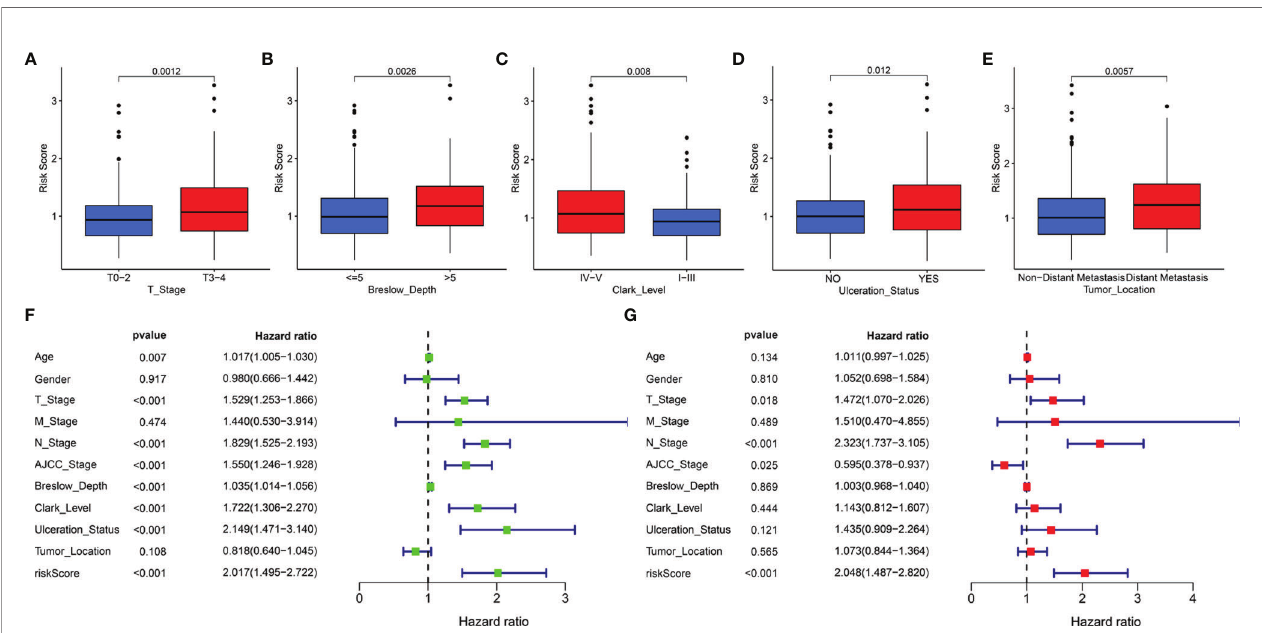
FIGURE 6 | The clinical utility of the LRG signature. The associations between the signature-based risk score and different clinical features, including (A) T stage, (B) Breslow depth, (C) Clark level, (D) Ulceration Status, and (E) Tumor Location. Univariate (F) and multivariate (G) Cox analyses for the signature-based risk score and other clinical features in TCGA cohort.